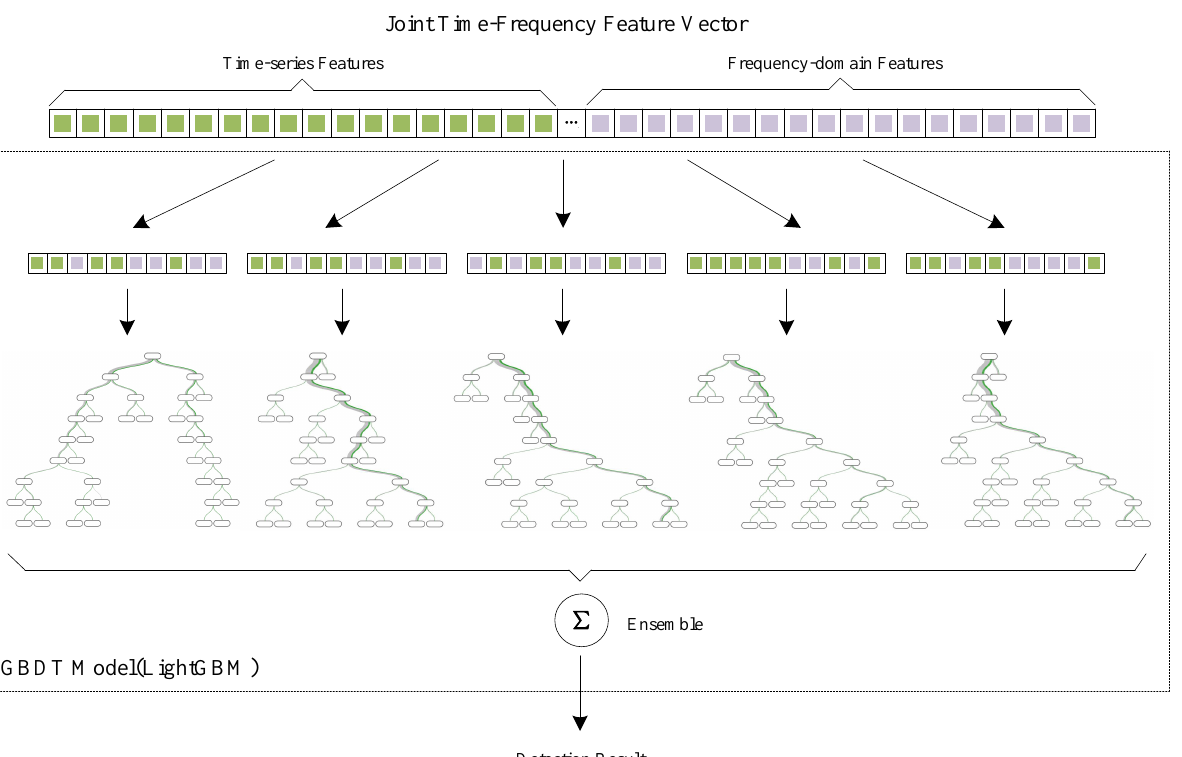
Figure 7. Architecture of GBDT-based detection